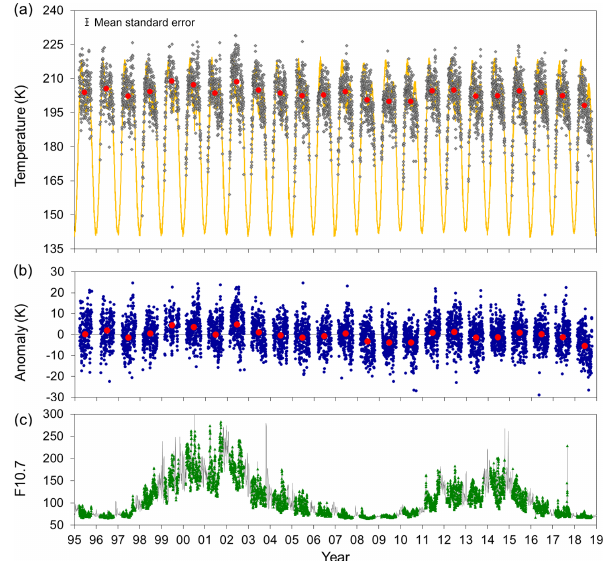
Figure 1. (a) Davis nightly mean temperatures (grey dots; 5309 samples) and winter mean temperatures (D106-259; red points) plotted over the NRL-MSISE00 model temperature for 68 ◦ S (87km altitude, local midnight values) for seasonal reference (Pi- cone et al., 2002; gold line). (b) Nightly mean and winter mean tem- perature anomalies derived by subtracting the climatological mean (see text). (c) Daily mean F10.7cm solar flux index (green points correspond to Davis OH temperature samples over the grey line, which are all daily